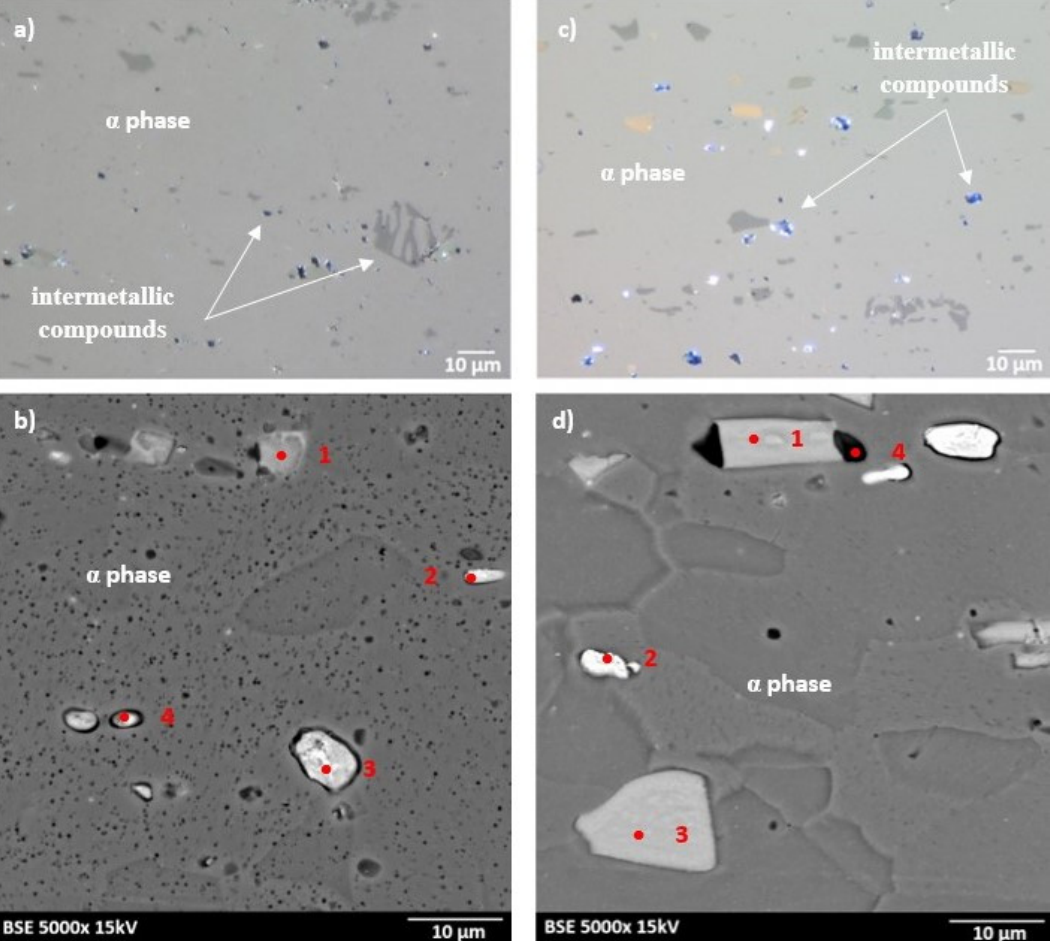
Figure 2. Microstructure of the AW-2024-T3 alloy in the initial state: ( a ) microstructure of bare AW-2024-T3 obtained by light microscope (LM); ( b ) microstructure of bare AW-2024-T3 obtained by SEM; ( c ) microstructure of clad AW-2024-T3 obtained by LM; ( d ) microstructure of clad AW-2024-T3 obtained by SEM .